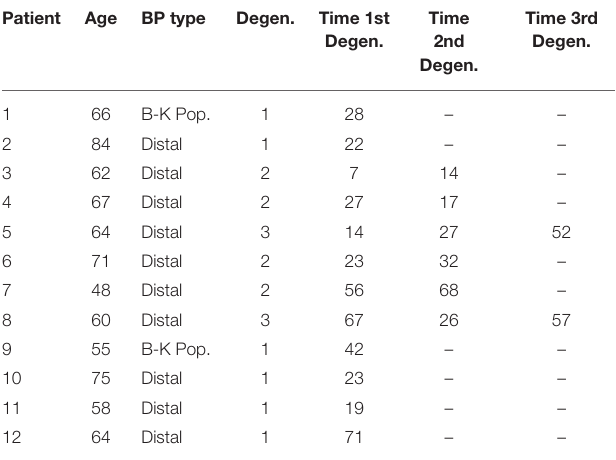
TABLE 3 | Allograft degenerations.